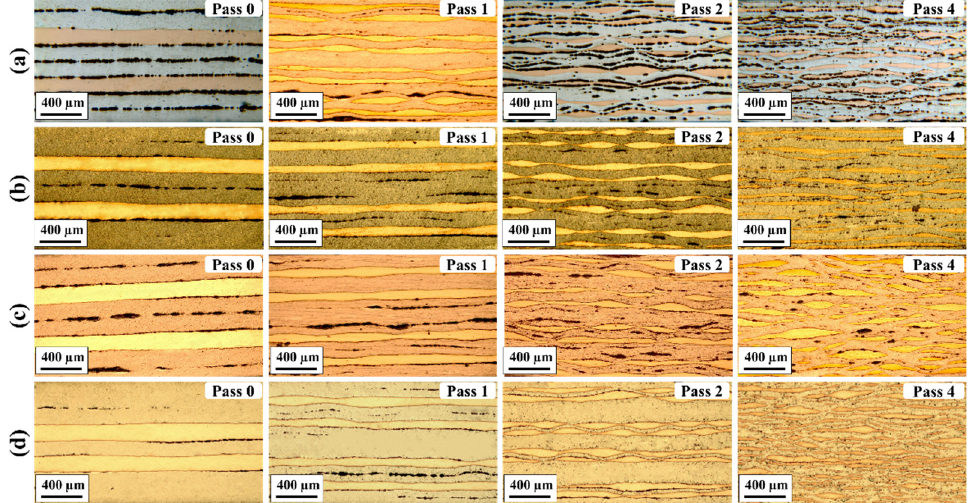
Figure 3. OM images of laminated composites: ( a ) ARBed-Al/Cu/3wt%SiC, ( b ) CARBed-Al/Cu/3wt%SiC, ( c ) ARBed-Al/Cu/2wt%SiC, and ( d ) CARBed-Al/Cu/2wt%SiC.